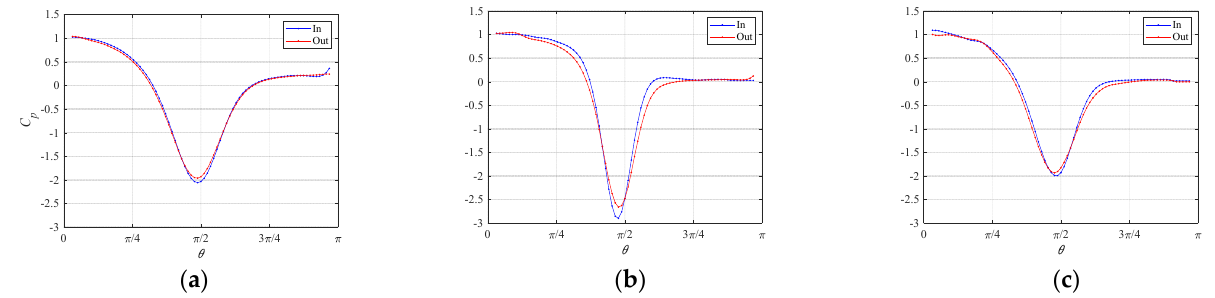
Figure 15. Pressure profiles at bubble surface: ( a – c ) are under same conditions as in Figure 8.